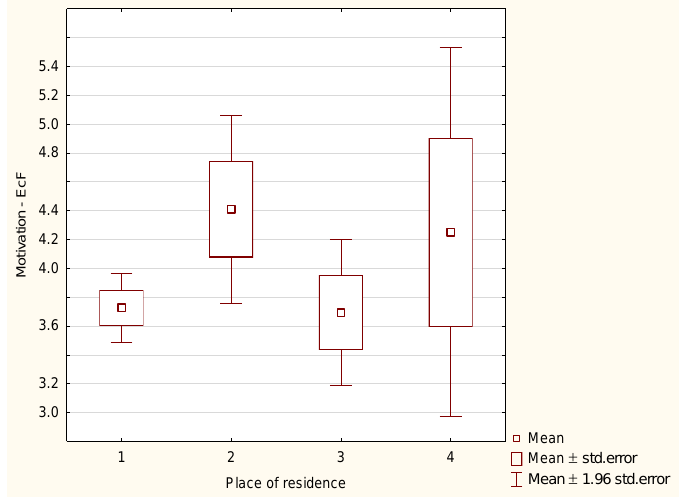
Figure 18. Ecological factors influencing the choice of transport depending on place of residence.